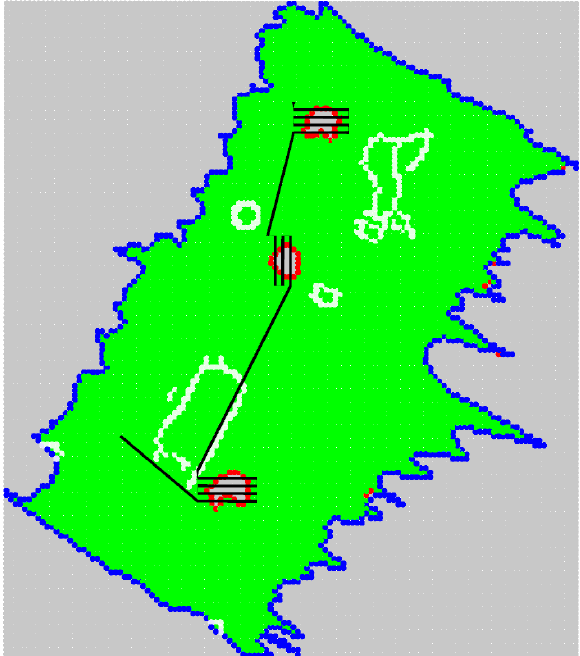
Figure 8. Experiments on Test site